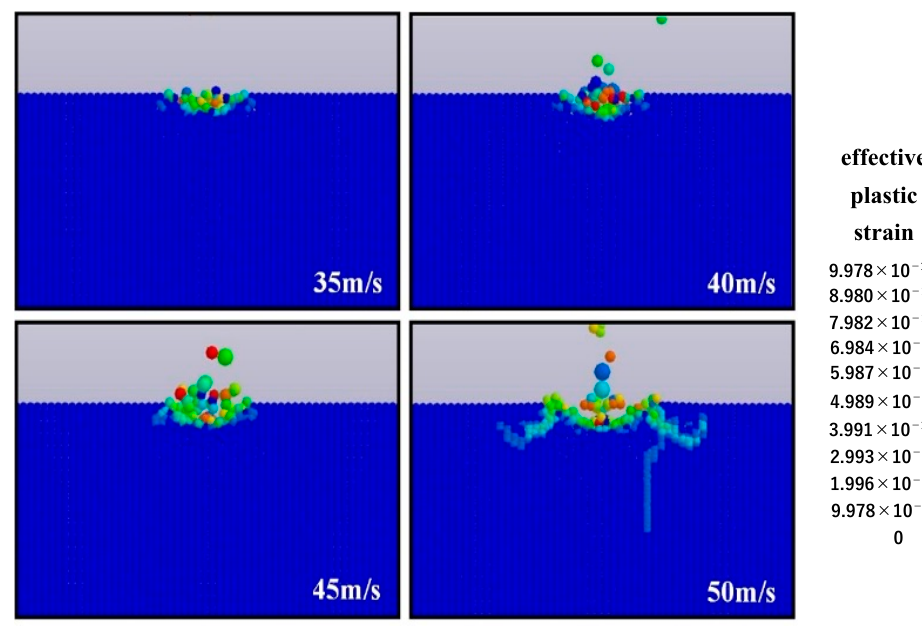
Figure 6. Surface morphology of impacted optical glass under different impact speeds.